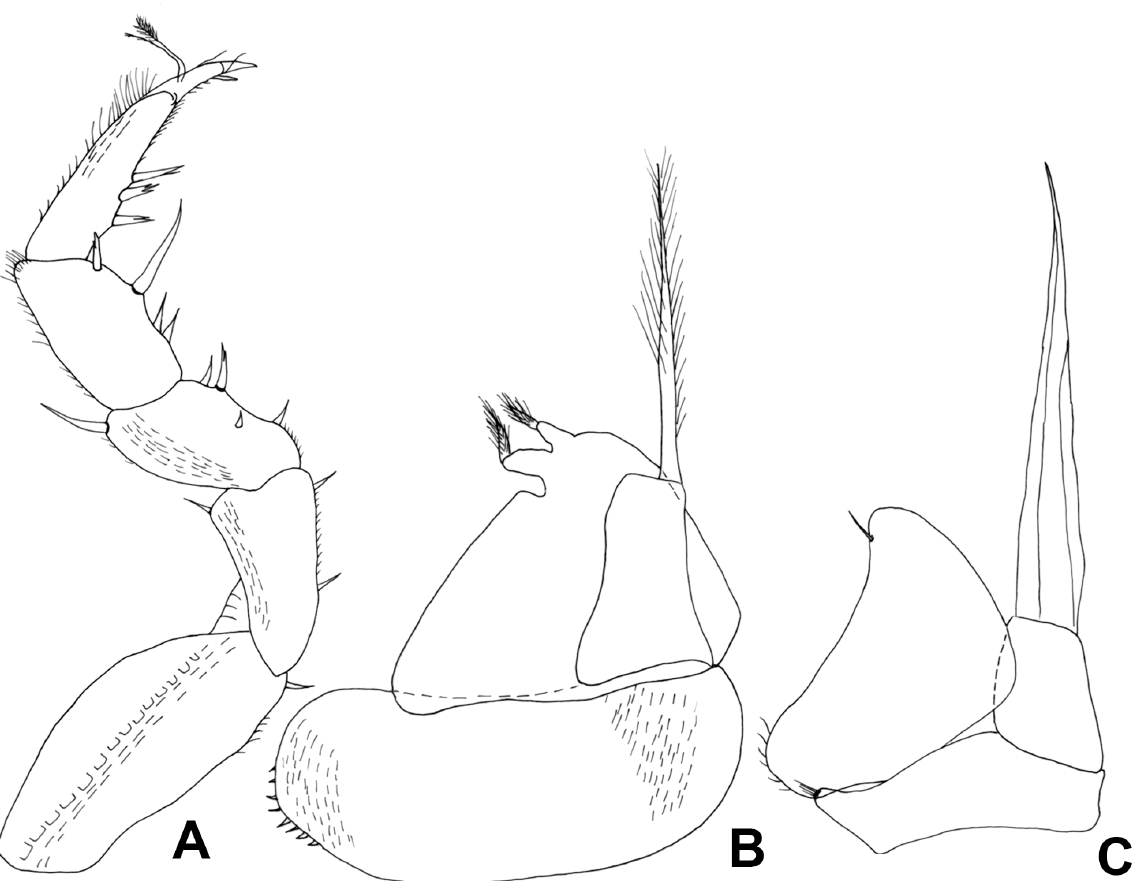
Fig. 2. Trichoniscoides machadoi Vandel, 1946 from Gruta d’el Rey, Cantanhede-Outil, ♂. A . Pereo- pod 7. B . Pleopod 1. C . Pleopod